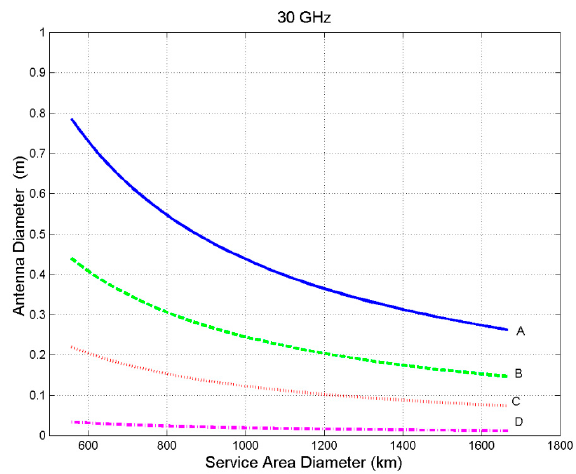
Figure 7. Antenna diameter as a function of the service area diameter, at 30 GHz for the GeoSurf constellation. A refers to h = 35,876 km; B to h = 20,000 km; C to h = 10,000 km, D to h = 1500 km.